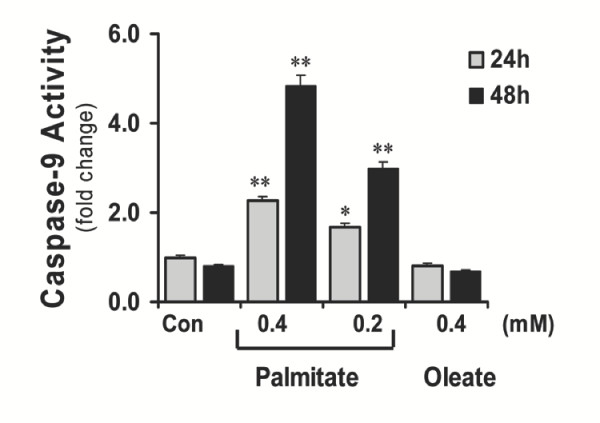
Palmitate but not oleate increases caspase 9 enzyme activity. HMC were treated with palmitate (0.2 and 0.4 mM) or oleate (0.4 mM) for 24 and 48 h. Caspase 9 activity was then measured in HMC extracts adjusted for total protein using a luminometric assay with an LEHD peptide substrate as described in Materials and Methods. Data are mean ± SEM for n = 3 experiments in duplicate. **, P < 0.01, *, P < 0.05 versus control or oleate alone by ANOVA.